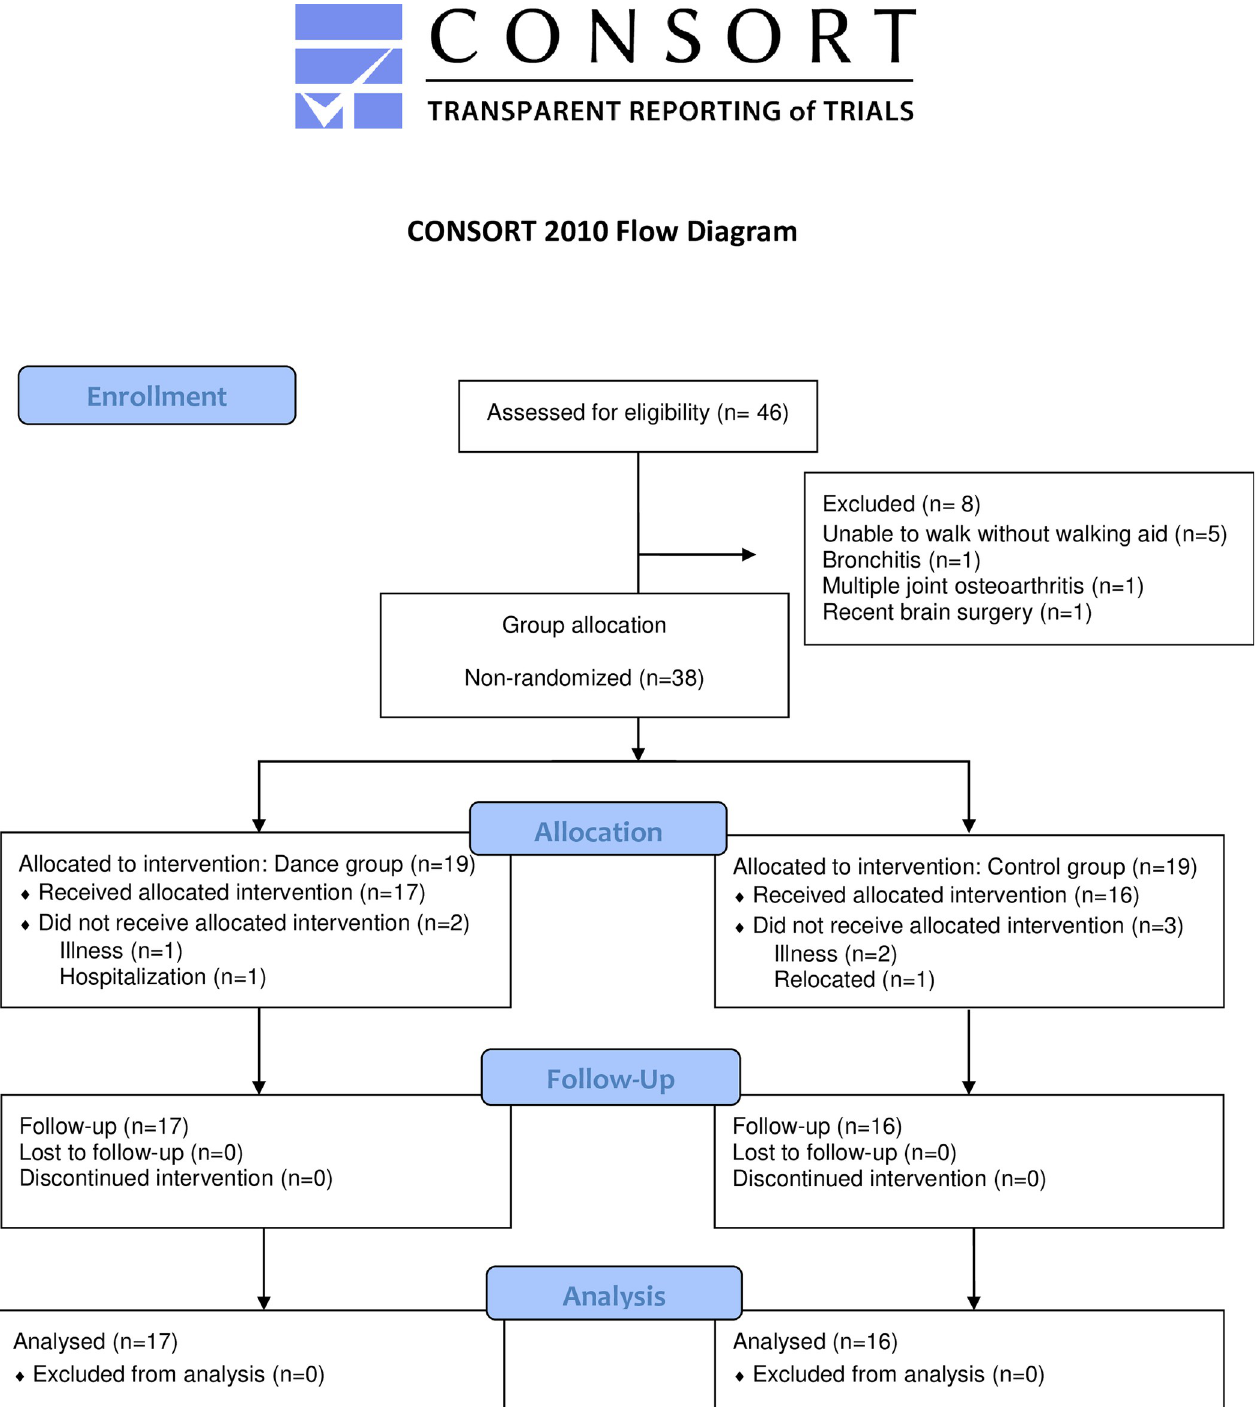
Fig 1. Consort diagram of participant recruitment, group allocation, and tracking over the course of the study.